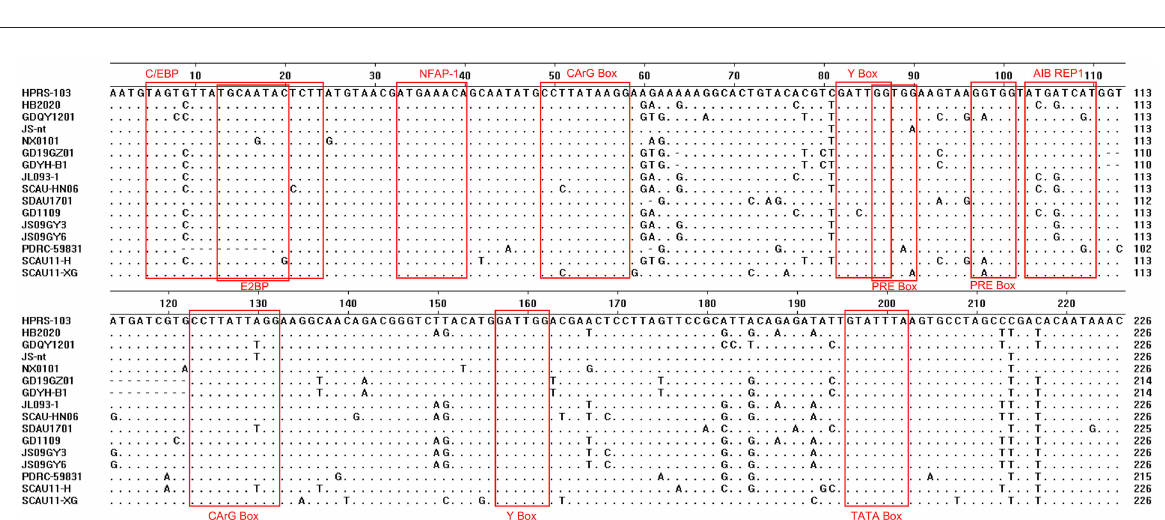
clustered in the liver (Figure 9B); splenic vascular endothelial cells were hyperplastic and clustered, with partial lymphocyte nuclei being absent (Figure 9D), and the kidney revealed a large number of myeloid tumor cells (Figure